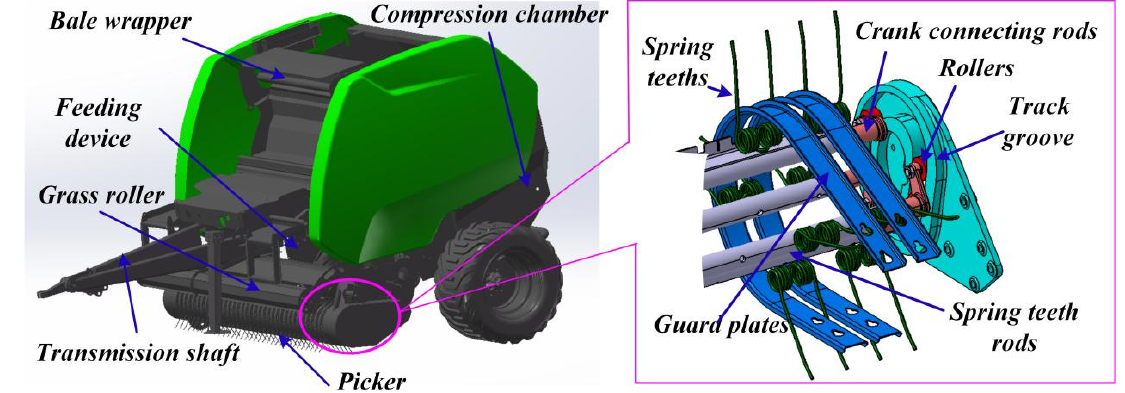
Figure 2. Composition structure of baler and picker.